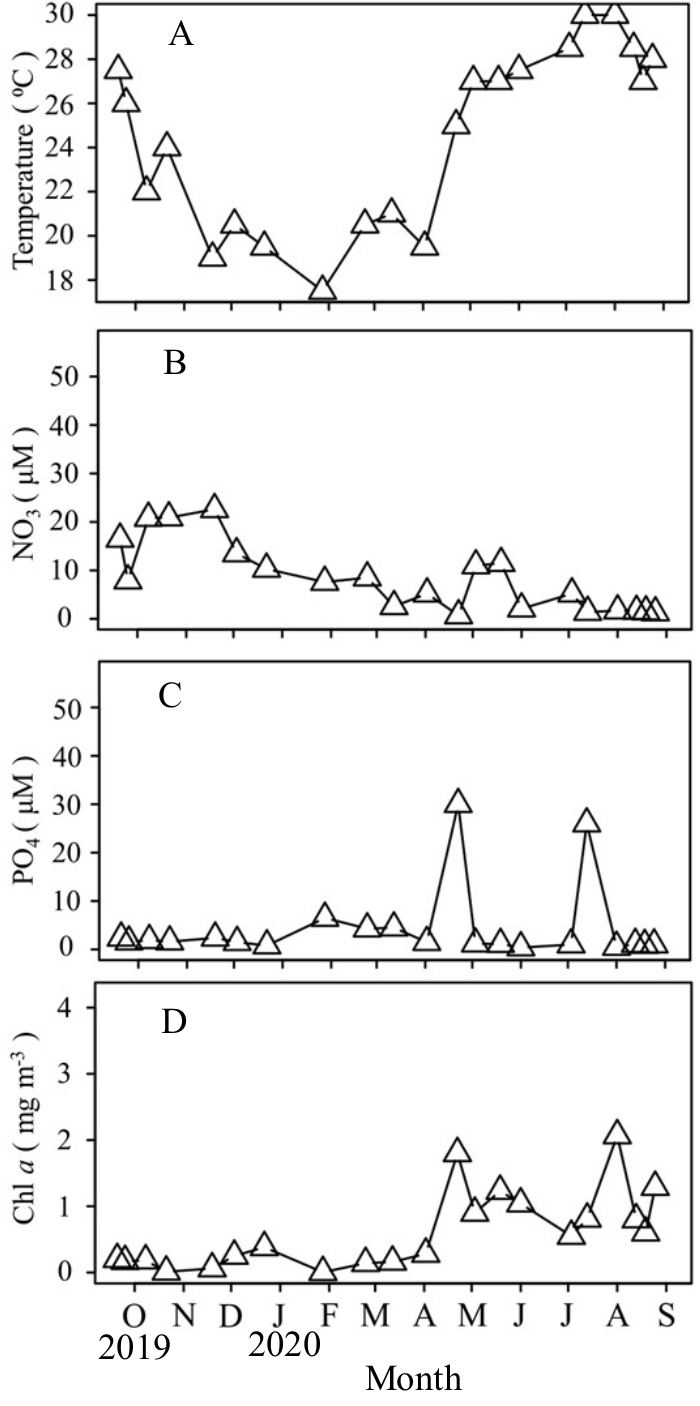
Figure 2. Seasonal variations of surface water temperature ( A ), NO 3 concentrations ( B ), PO 4 concen- trations ( C ), and Chl a concentrations ( D ).